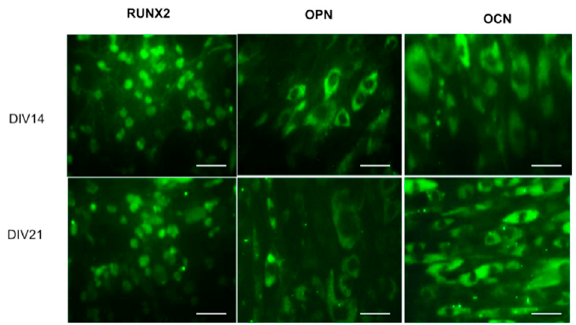
Figure 8. Differentiation of HDPSCs. Expression of RUNX-2, OPN, and OCN at days 14 and 21, (40× magnification). Scale bar 100 µm. Reproduced from Martín-del-Campo et al. [16], with permission from The Royal Society of Chemistry.